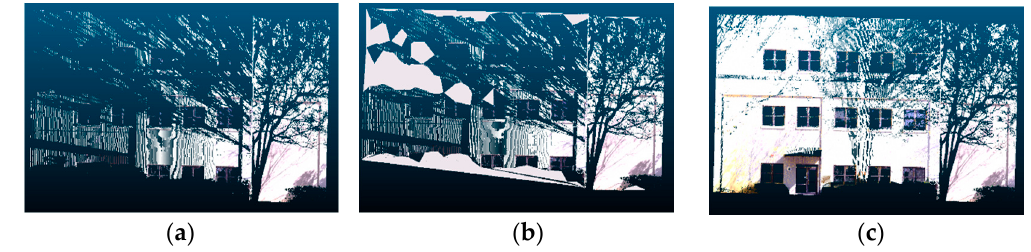
Figure 16. Example of a hole-filling limitation. ( a ) Input, ( b ) building facade after hole-filling, and ( c )